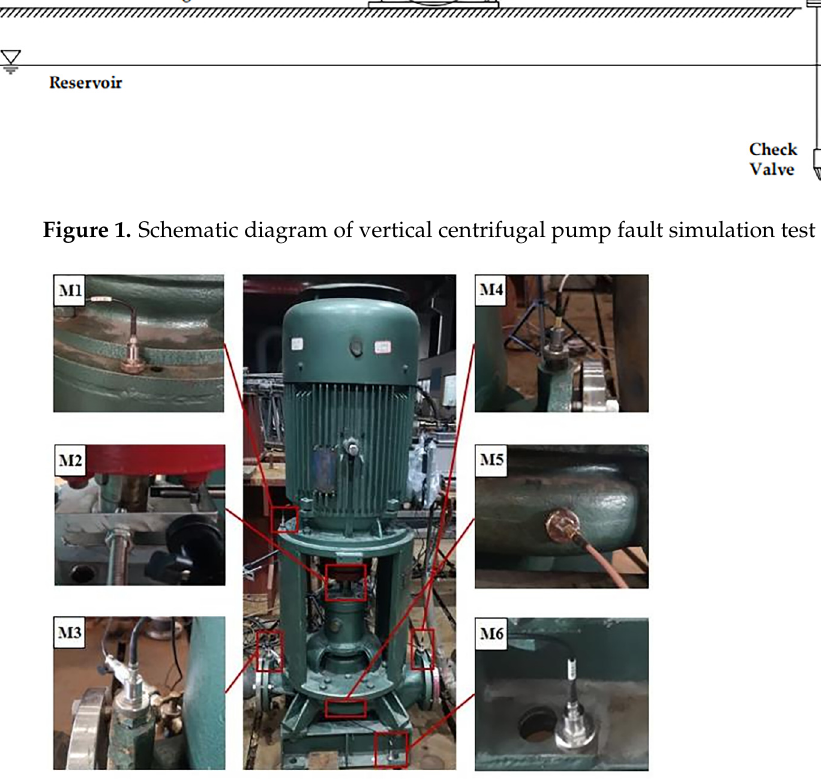
Figure 2. Physical layout of sensor measuring points. Table 1. Sensor measuring point number information table .